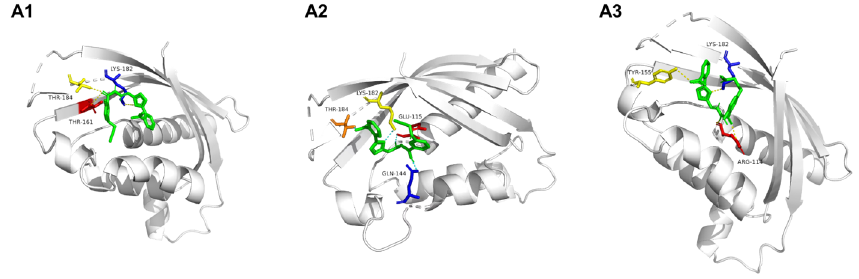
Figure 8. Docked view of compounds A1 , A2, and A3 at the active site of the enzyme PDB: 4AKY. Table 2. The binding free energy.